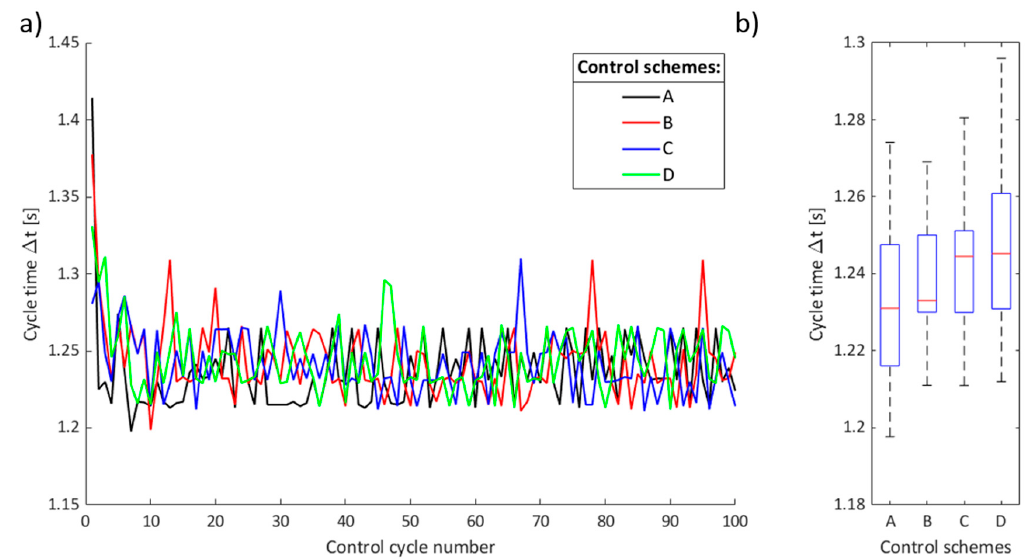
Figure 7. Timing results for the main control loop implementation in MATLAB. ( a ) Cycle times for A, B, C, and D control schemes; ( b ) cycle times’ boxplots for the A, B, C, and D control schemes.